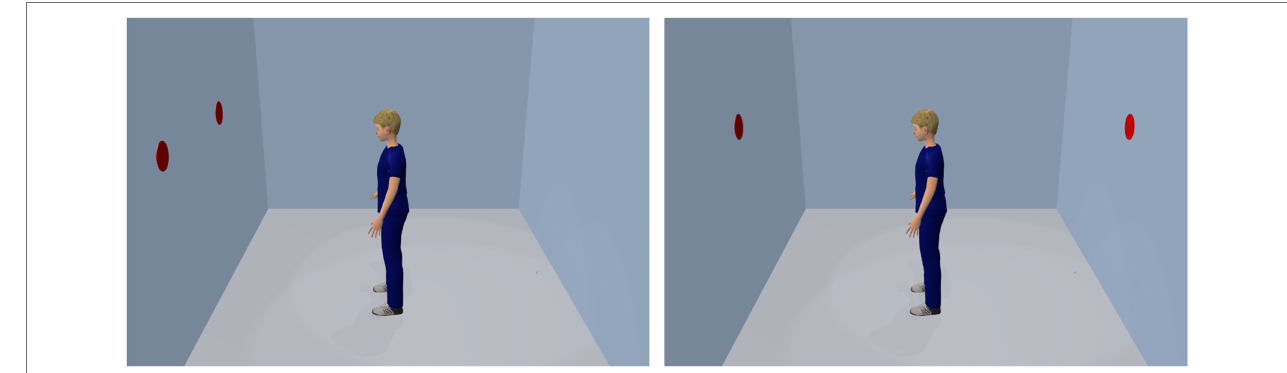
FIGURE 3 | The dot-perspective task of Samson et al. (2010). Participants responded to the number of dots on the display. Reaction times are typically facilitated when the participant sees the same number of dots as the avatar ( left panel ), compared to when they see a different number ( right panel